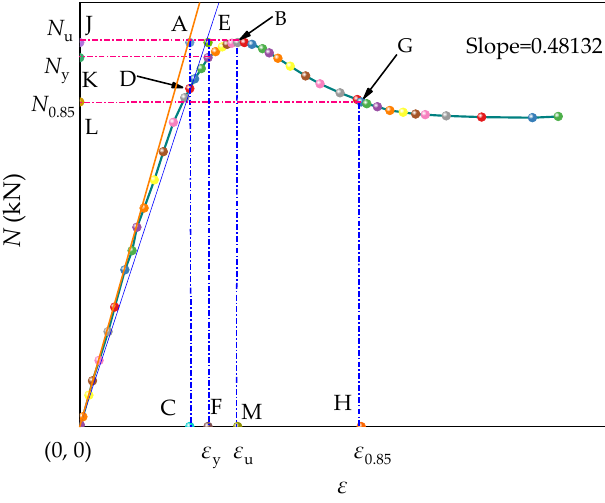
Figure 7. Graphic illustration of geometric drawing.